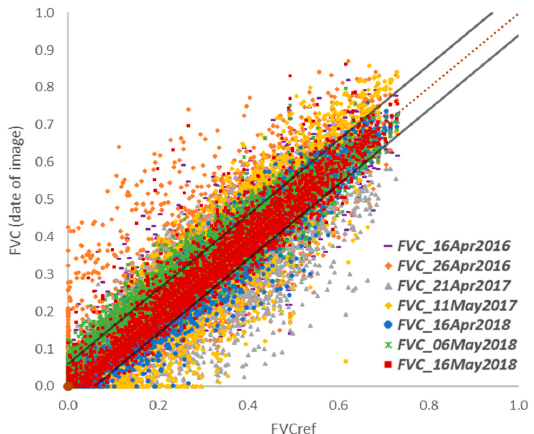
Figure 4. Relationship between the average FVC values of the reference image and those of the component images.